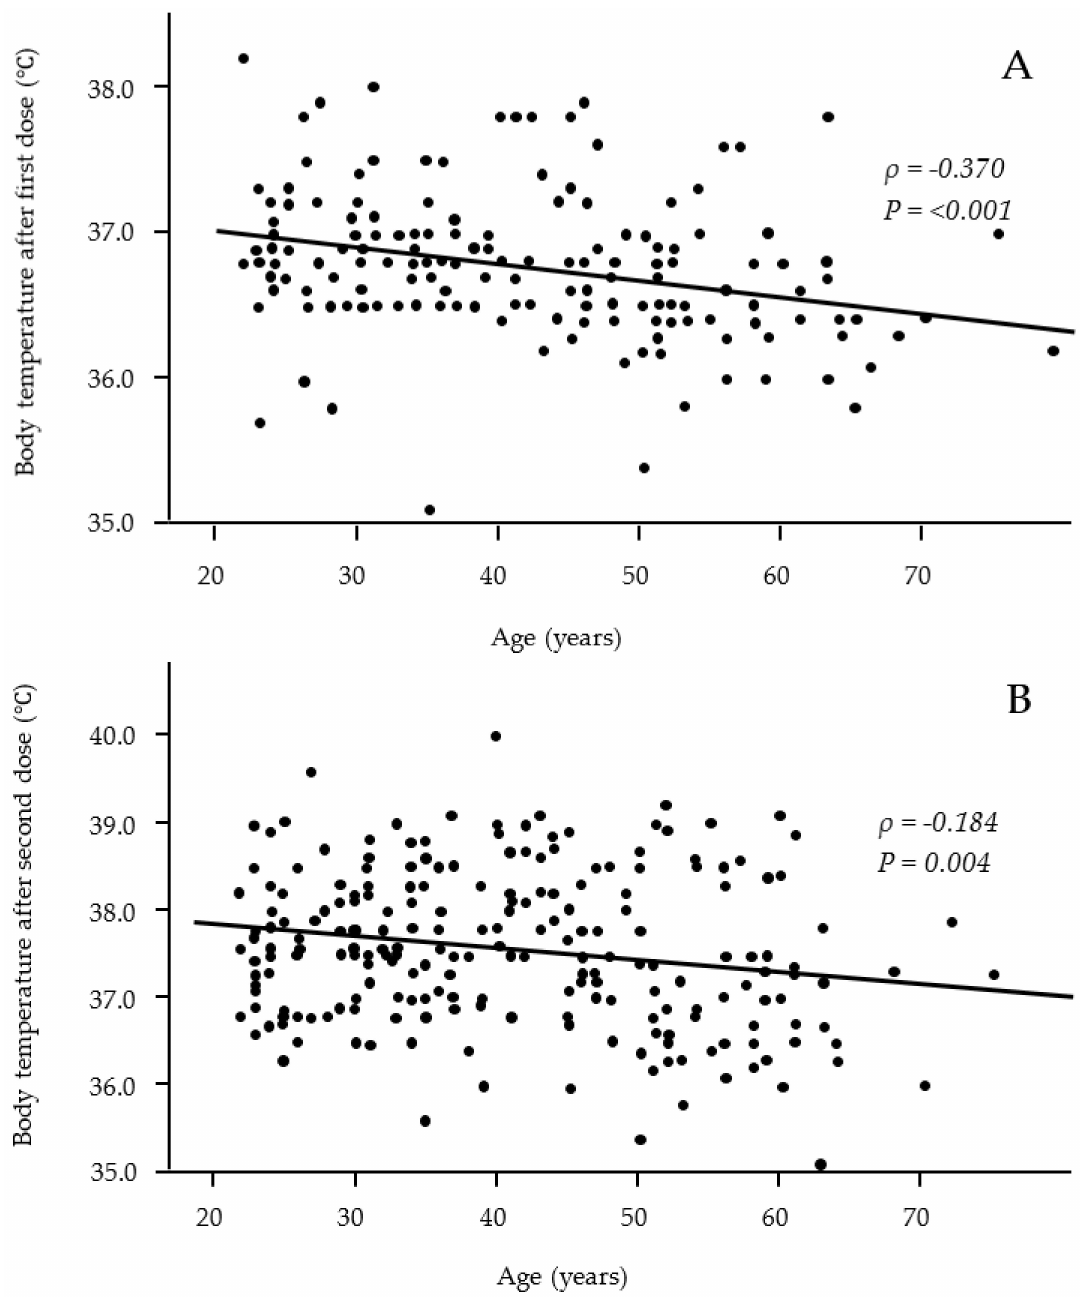
Figure 1. Relationships between age and body temperature after the first ( A ) and second ( B ) vaccine doses. Significant negative correlations were observed after both the first and second vaccine doses. ( A : n = 176; B : n =